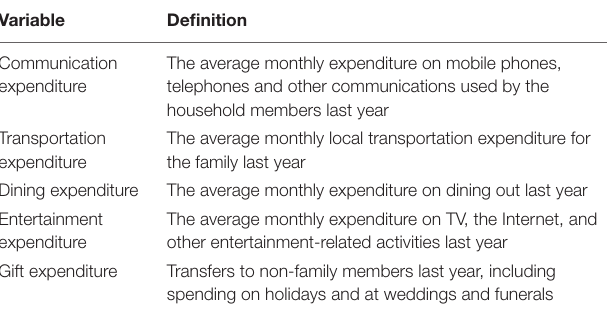
TABLE 2 | Questions in the 2015 CHFS related to financial literacy.